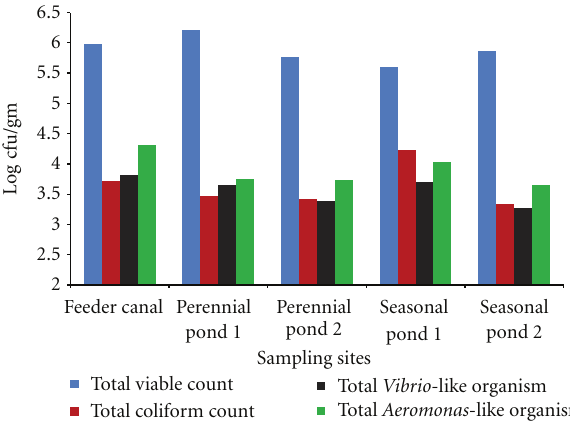
Figure 2: Mean value of bacteriological count of sediment from di ff erent sampling sites.